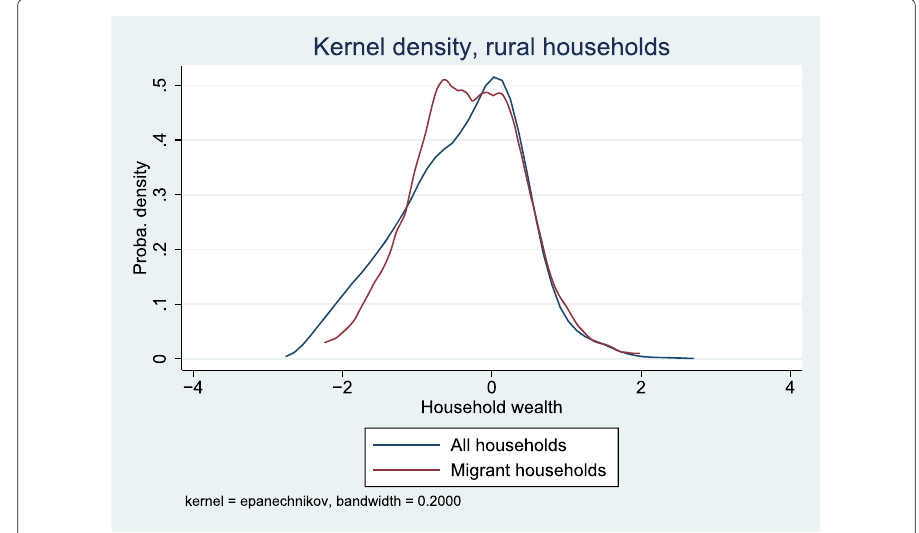
Fig. 2 Household wealth and migration: rural